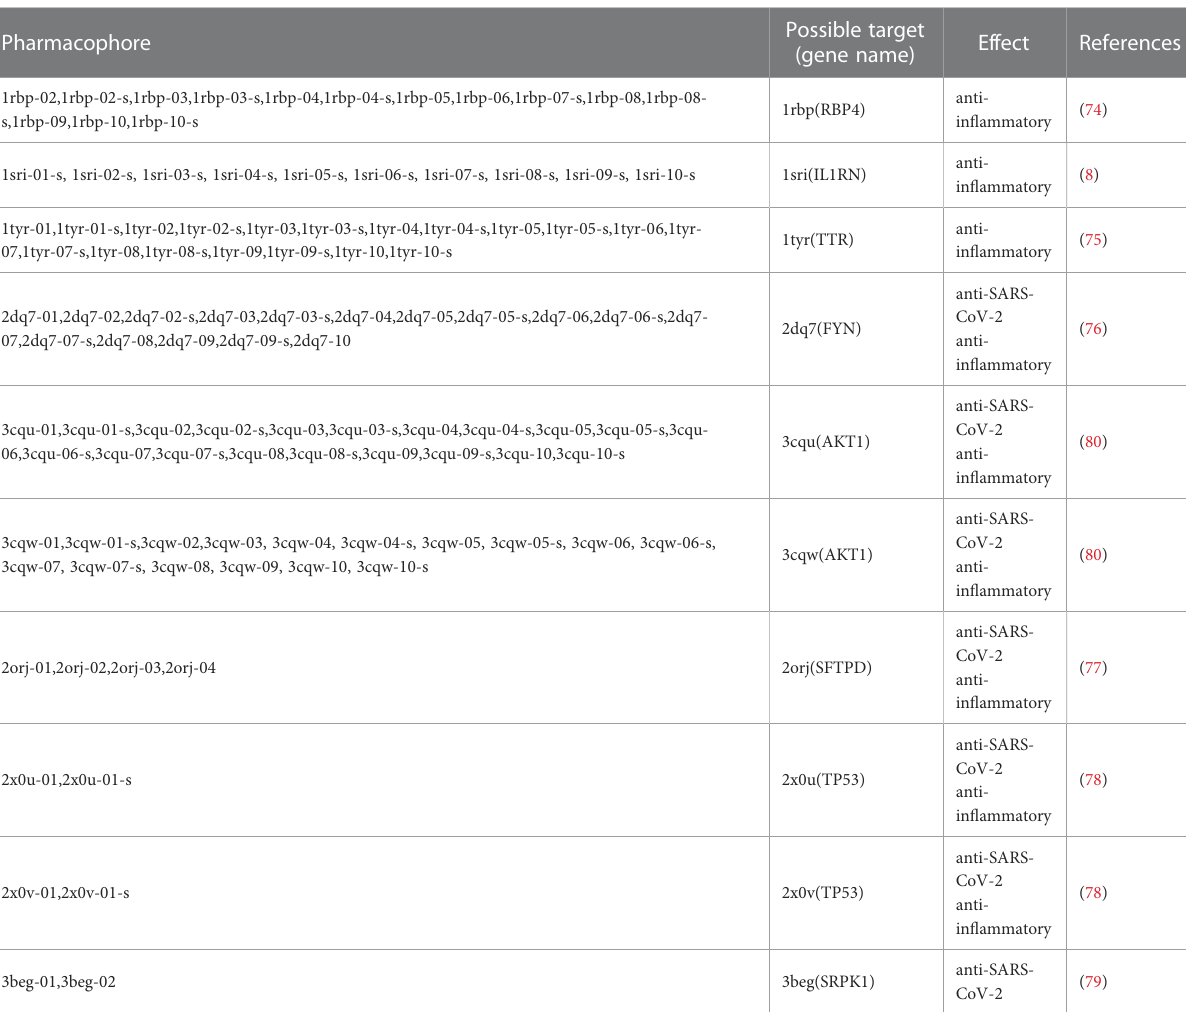
TABLE 2 All pharmacophores and their possible corresponding targets obtained by reverse fi nding target.